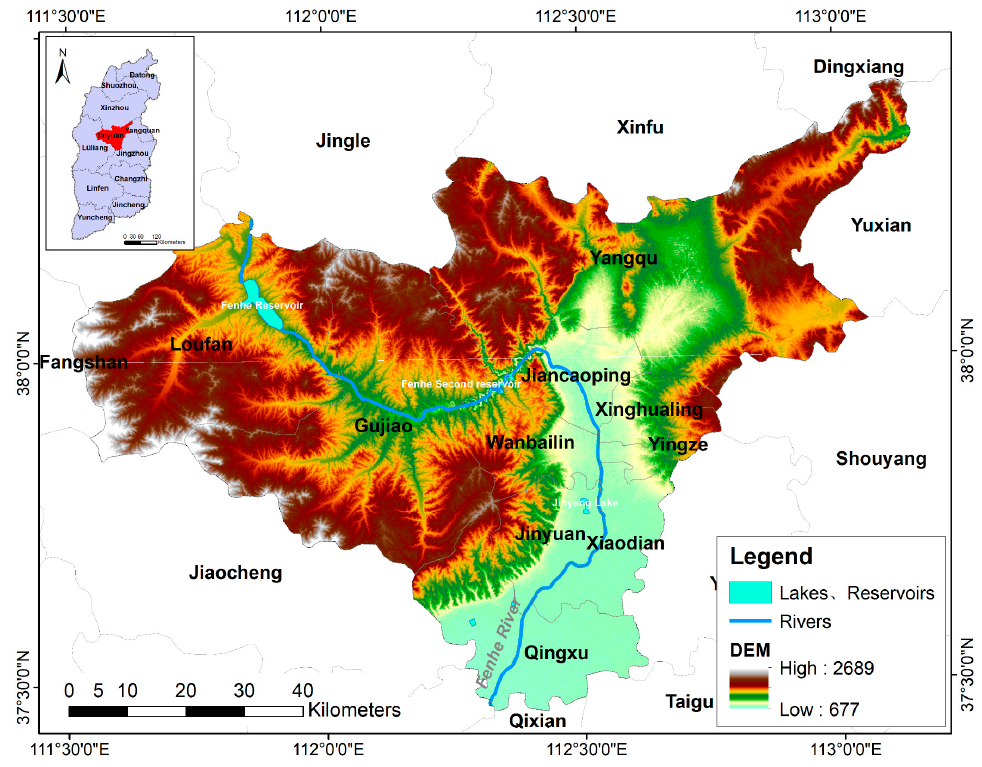
Figure 1. Location of the study area.